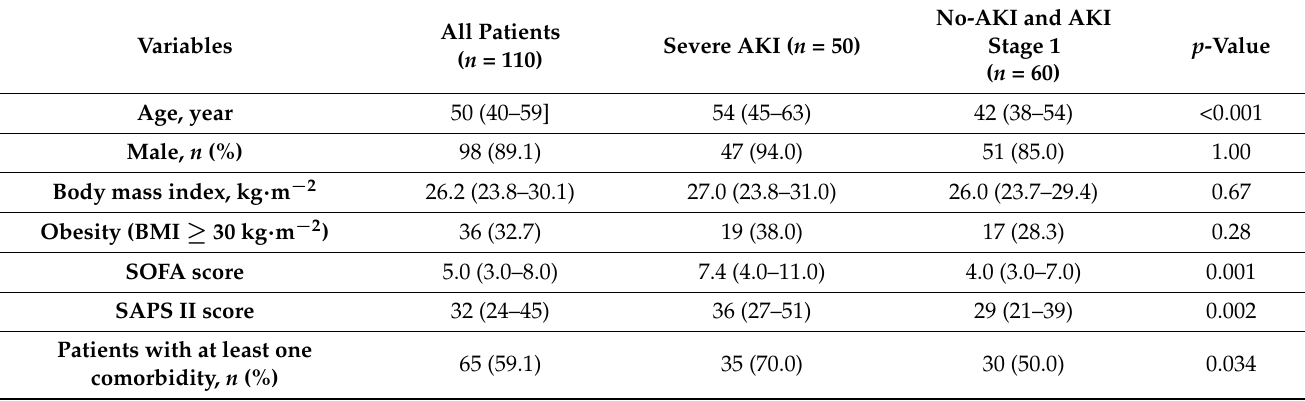
Figure 1. Flow chart of COVID-19 patients admitted to the intensive care unit (ICU). AKI: acute kidney injury. Table 1. Comparisons of baseline characteristics, laboratory data, and treatments during ICU stay between severe AKI (stage 2 and 3) and AKI stage 1 and no-AKI groups.